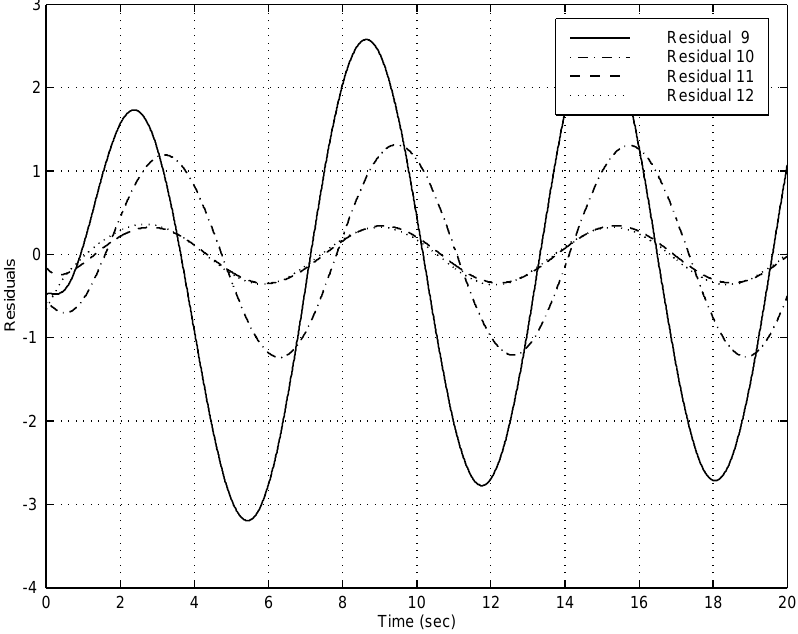
Fig. 4. Residuals 9–12 for 4 mode simulation with δ 1 = 0 . 005 .